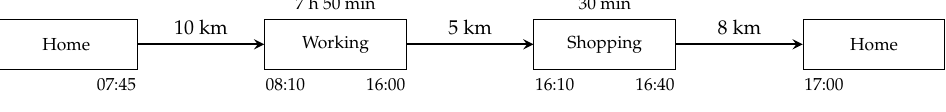
Figure 4. Example of a general mobility